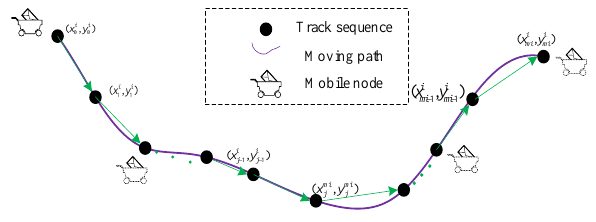
Figure 1. Discrete and continuous moving paths.